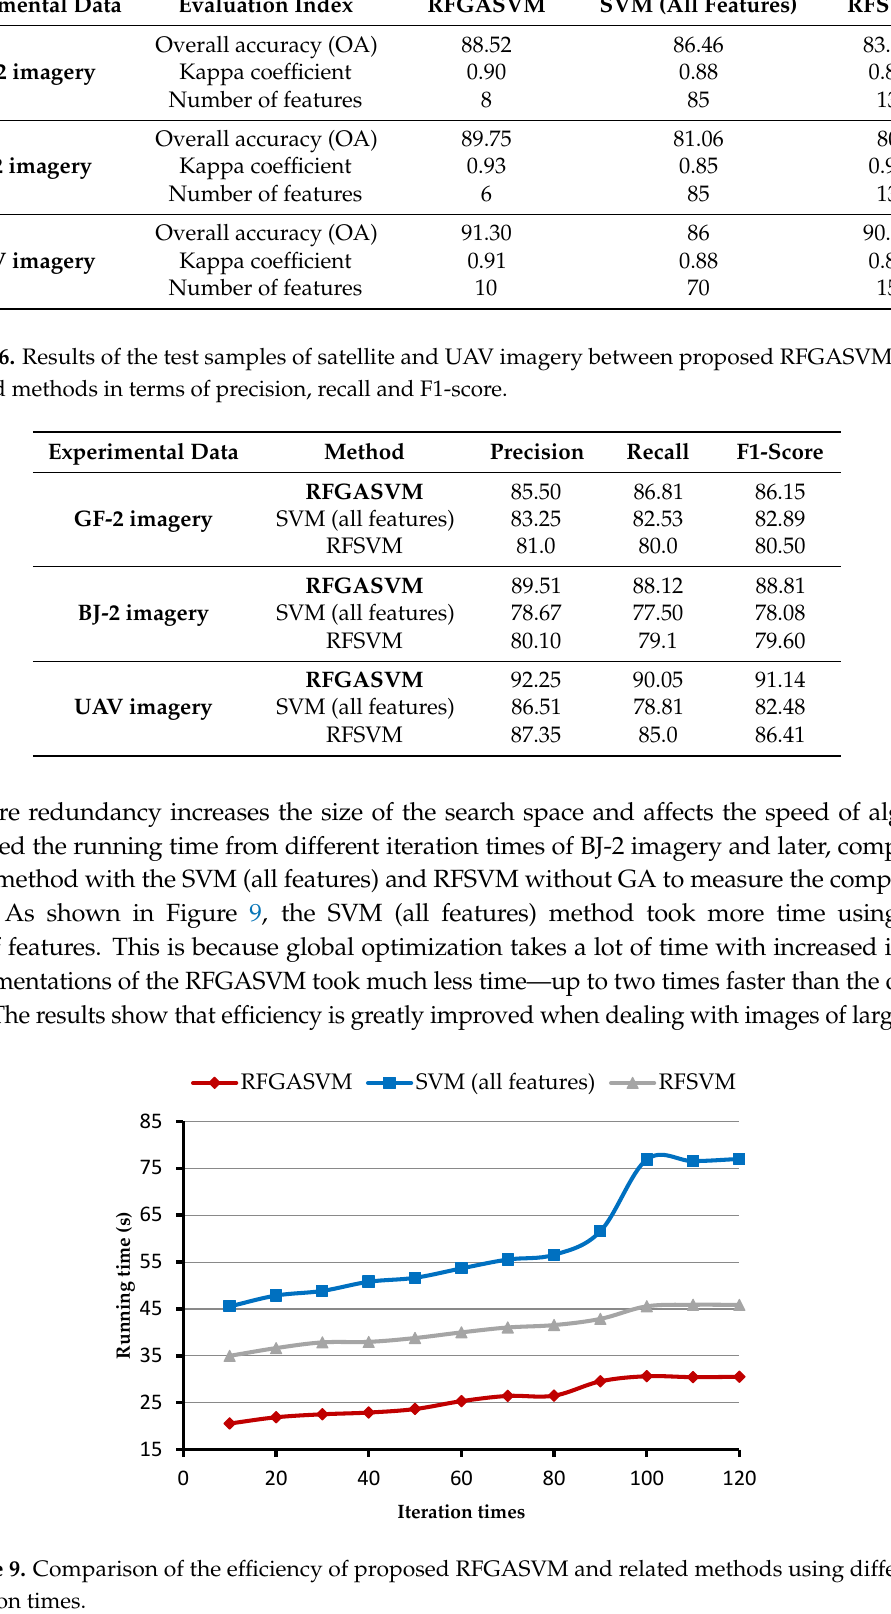
Table 5. Comparison among RFGASVM and related methods.